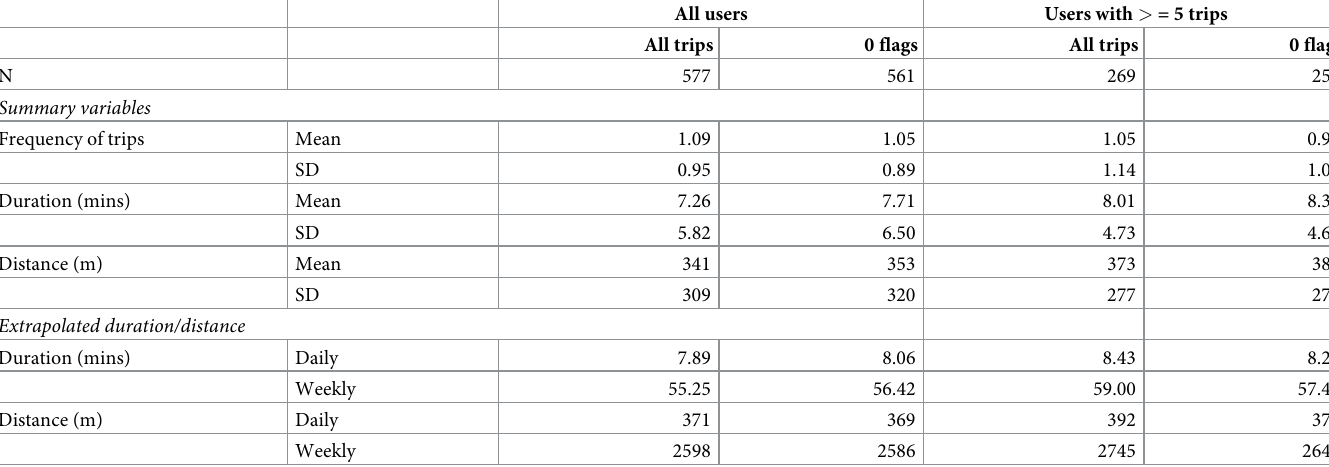
Table 5. Average frequency, distance and duration of trips, and total distance and duration extrapolated to daily and weekly